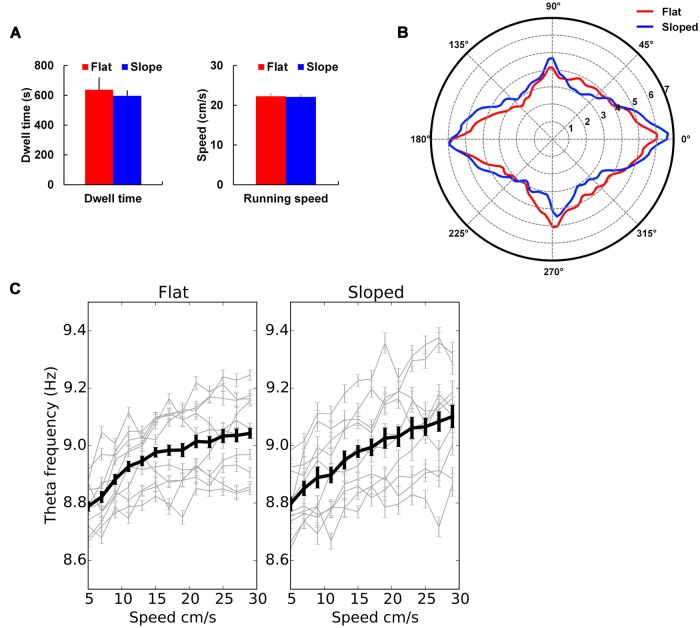
Behavioral and local field potential (LFP) analyses. (A) Mean dwell time and speed for the flat and sloped halves of the gradient box ± SEM. (B) Mean directional dwell time for the flat and sloped halves showing pronounced peaks aligned with the main axes of the recording environment, i.e., North–South and East–West. (C) Theta–speed relationship in both parts of the box showing no difference in theta–speed relationship between the two sections. Means ± SEM are shown with mean across all trials in thick black line and individual trials shown in light gray lines.